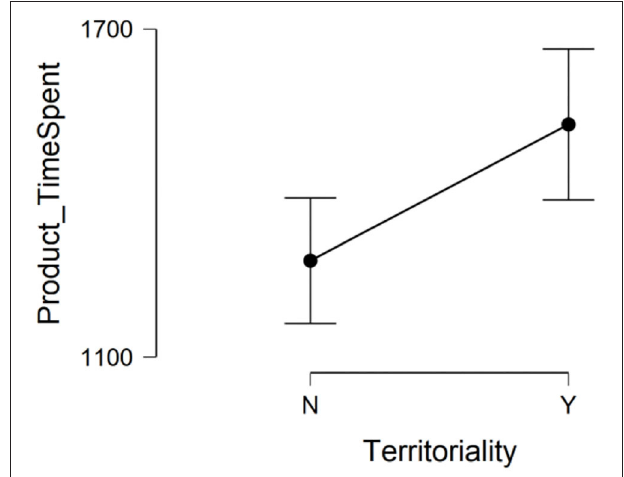
FIGURE 2 | Plot 2 – product time spent/territoriality relation.